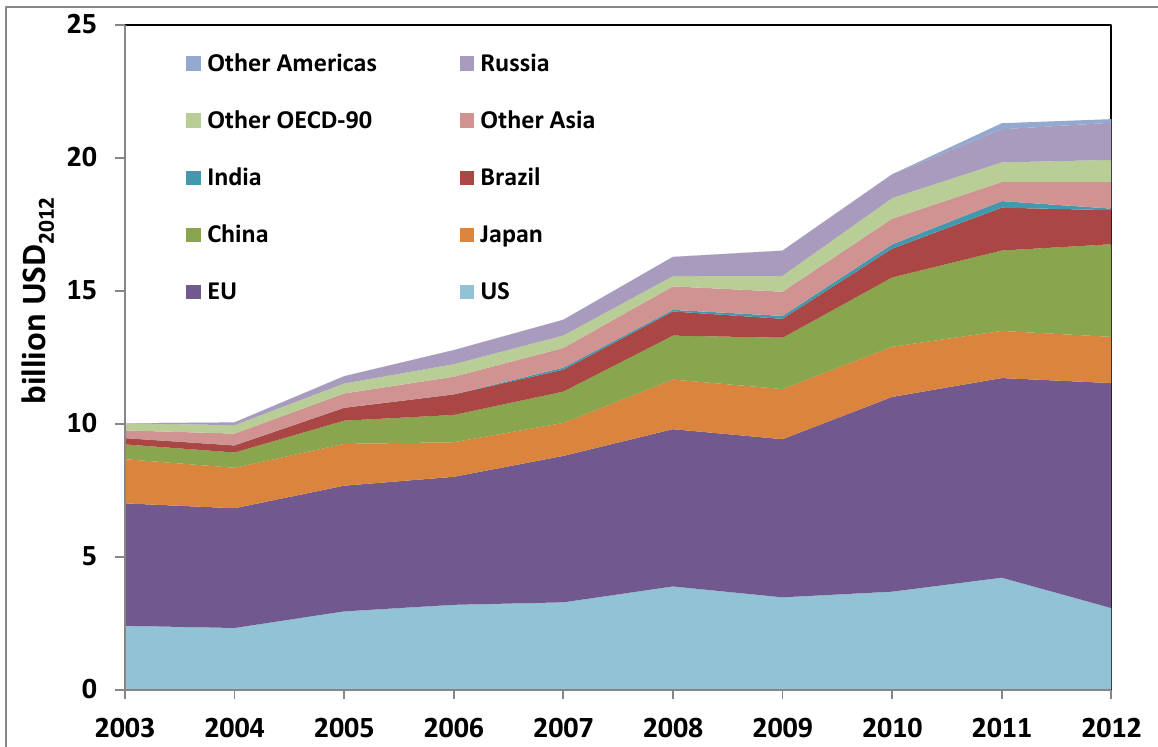
annually on 2012